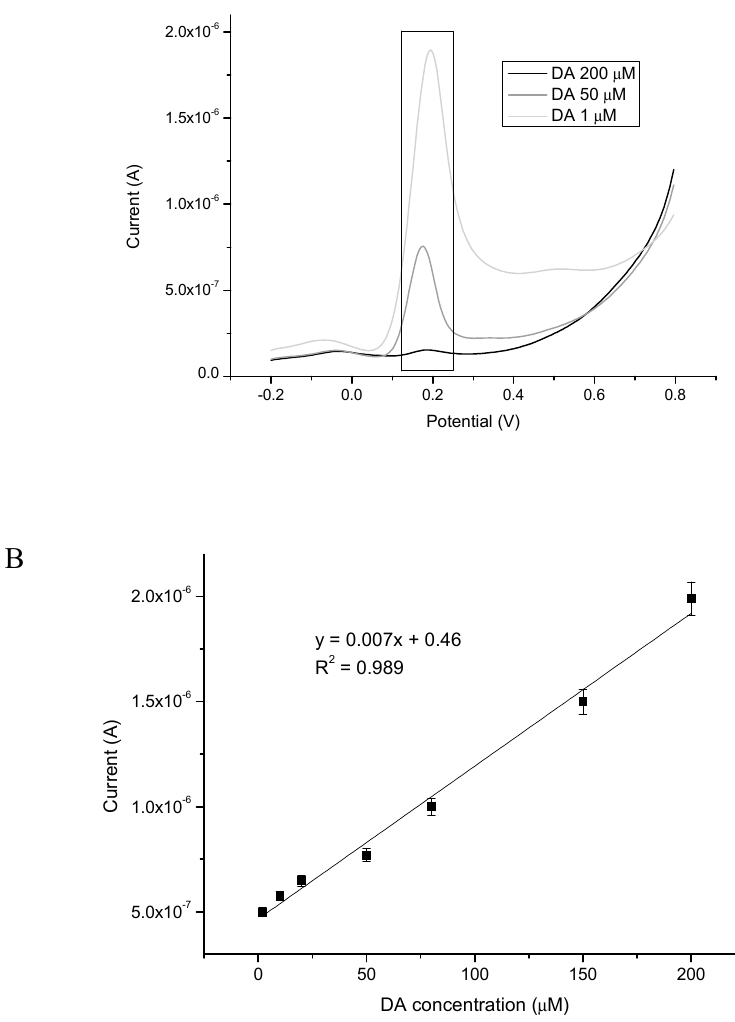
Figure 12. ( A ) Representative differential pulse voltammetry (DPV) scans for increasing DA concentrations (1, 50, and 200 µ M), and ( B ) relationship between the DA concentration and current (biosensor response). Table 3. Comparison of biosensors and sensors for DA detection.